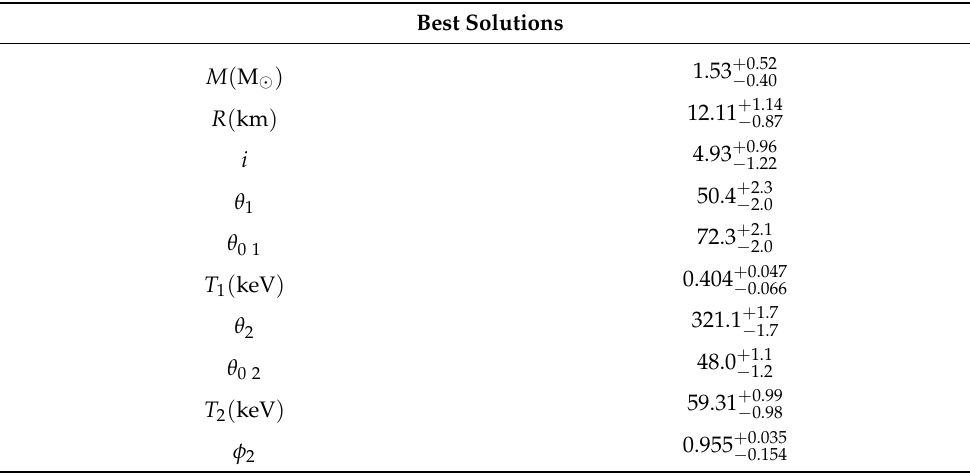
Figure 7. Phase diagrams for different values of angular semi-aperture θ 0 . The results are calculated for a column of height H = 1.0 km. The parameters are M = 1.4 M (cid:12) , R = 12.0 km, i = 90 ◦ , P = 1 s, θ = 45 ◦ , and φ = 180 ◦ , T = 0.7 KeV. Table 1. Best solutions with the parameters of the two accretion